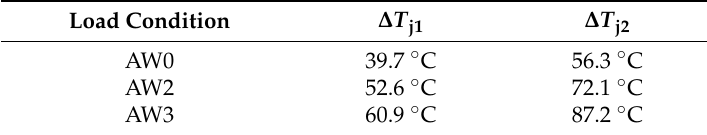
Table 2. ∆ T j of Q 32 and D 32 under different load Table 2. Δ T j of Q 32 and D 32 under different load conditions.